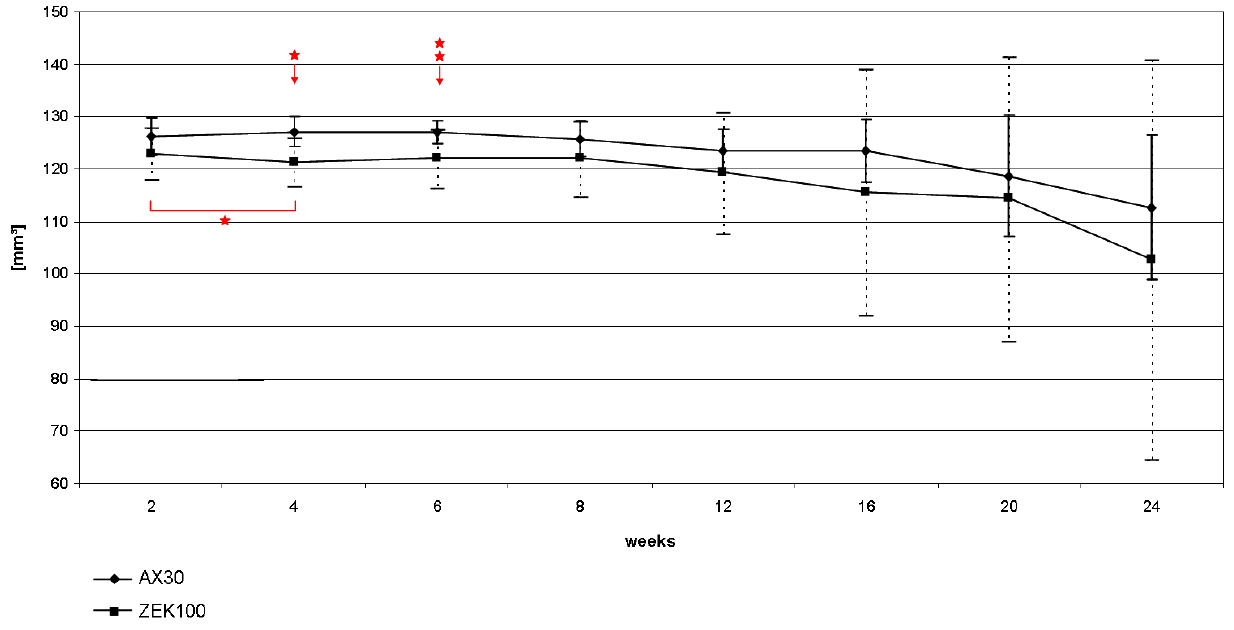
Figure 1. Loss of volume of the implants during implantation measured by the in vivo